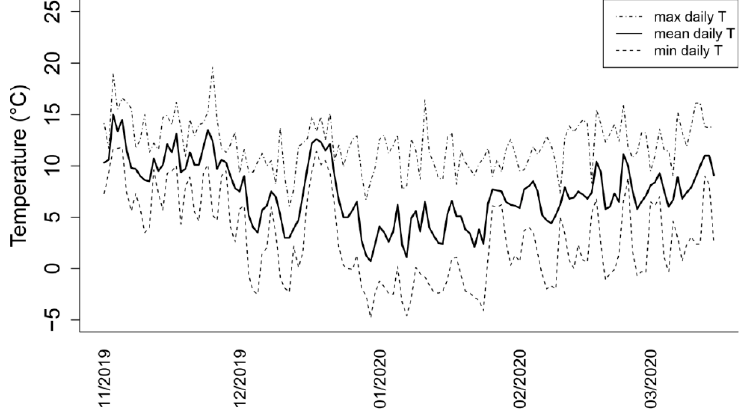
Figure 2. Daily temperatures data registered during the 2019–2020 winter season.